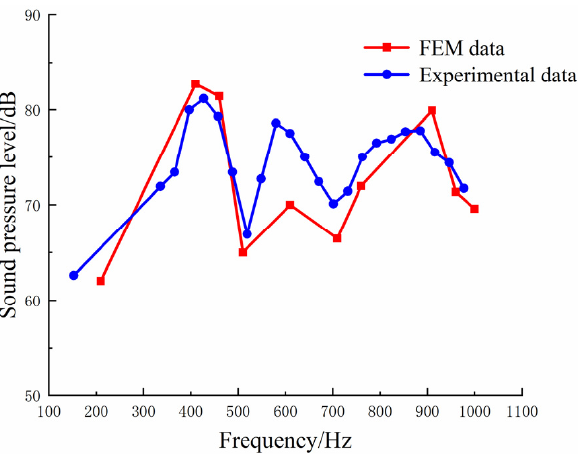
Figure 10. Comparison of sound pressure level test and FEM results (2200 r/min).